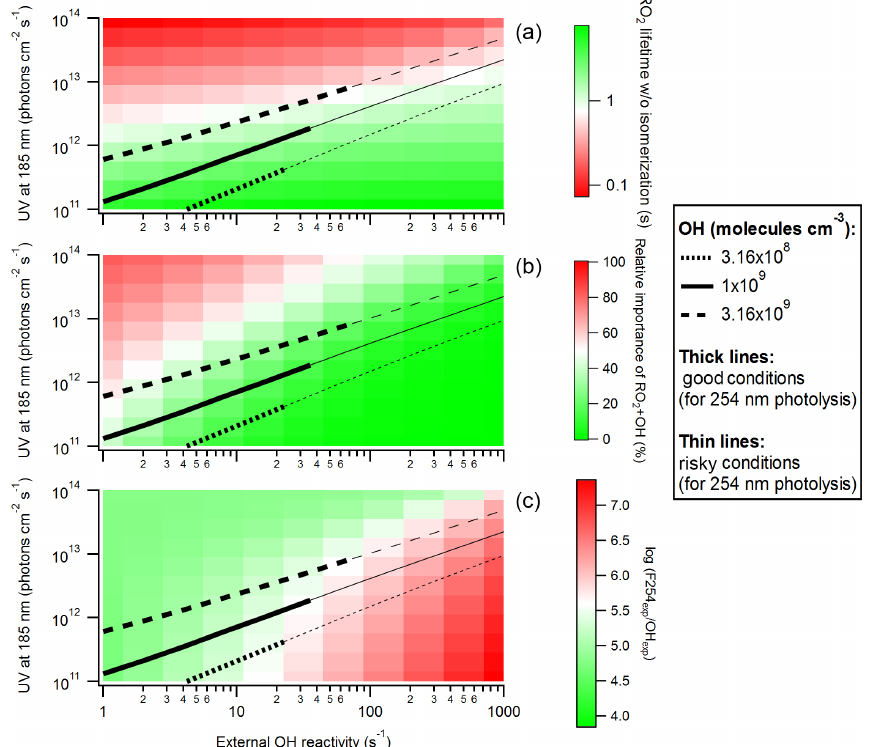
Figure 7. (a) RO 2 lifetime in the absence of isomerization, (b) relative importance of RO 2 + OH in RO 2 fate, and (c) logarithm of the exposure ratio between 254nm photon flux and OH as a function of 185nm photon flux and external OH reactivity for OFR185 at N 2 O = 0 and H 2 O = 2 . 3%. Three lines denoting conditions leading to OH of 3 . 16 × 10 8 , 1 × 10 9 and 3 . 16 × 10 9 moleculescm − 3 are added in each panel. The thick and thin parts of these lines correspond to good and risky conditions (in terms of 254nm organic photolysis, which is usually worse than 185nm organic photolysis; Peng et al., 2016),